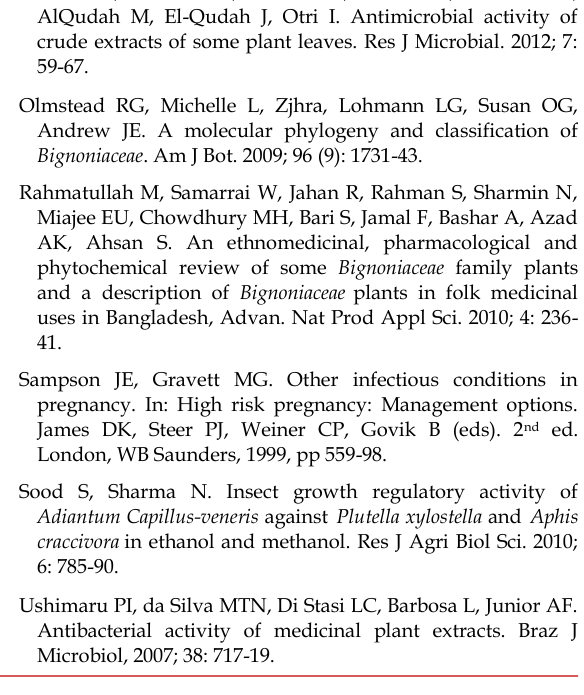
IR spectra of ethanol extract for functional groups IR values (Frequency, cm -1